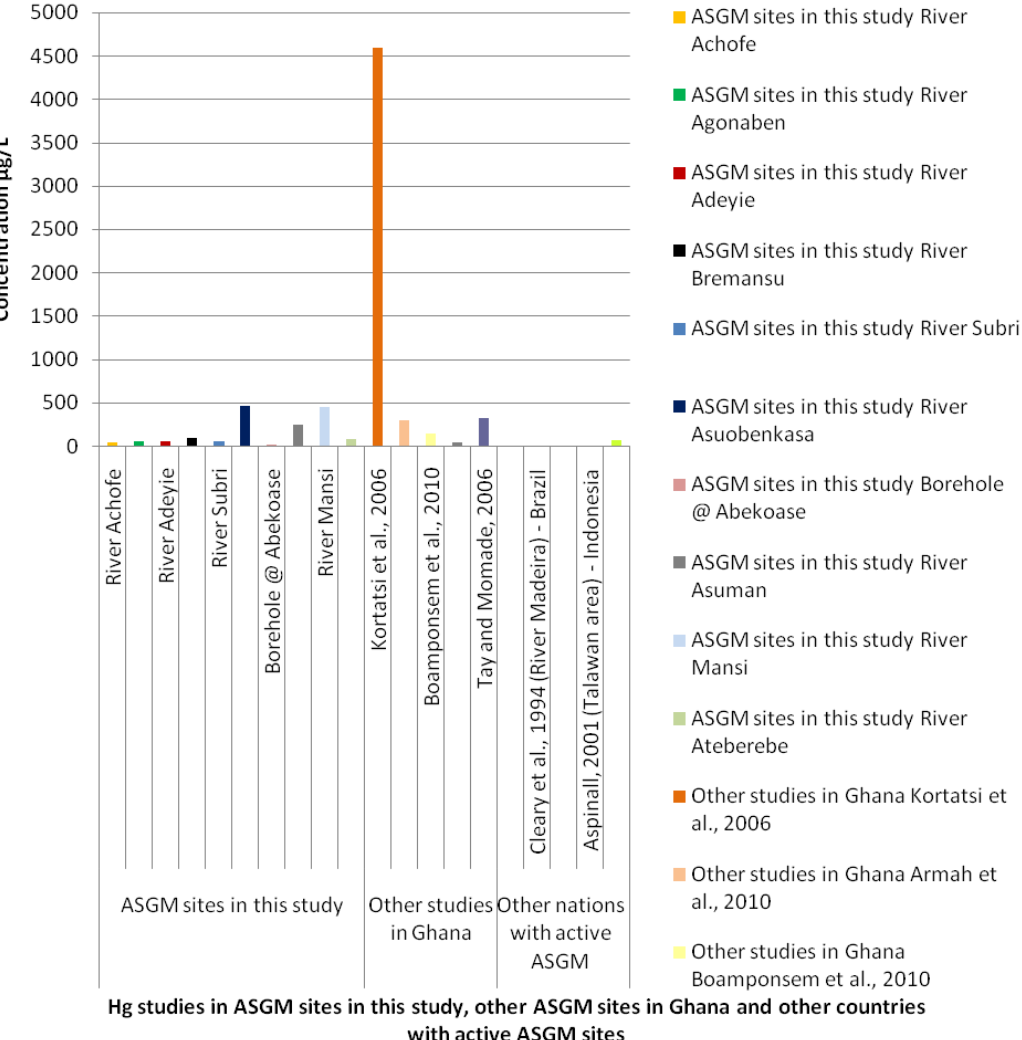
Figure 3. A graph comparing Hg levels in water samples from ASGM sites in this study with other ASGM sites in Ghana as well as other countries with active ASGM sites [6,28–30,32–